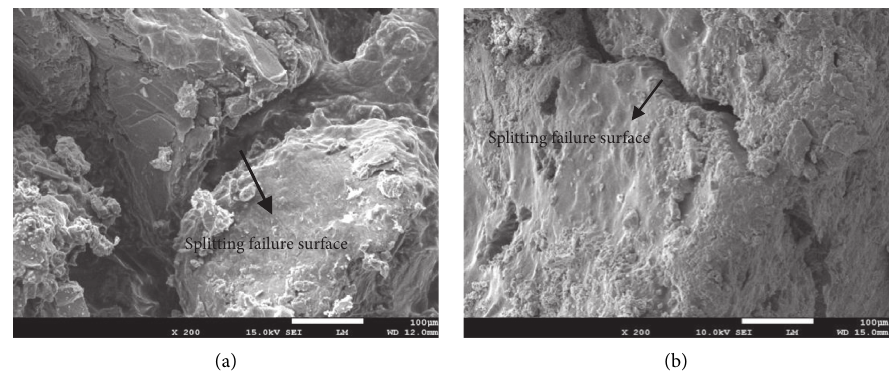
Figure 15: Breakdown of asphalt mixture without fiber